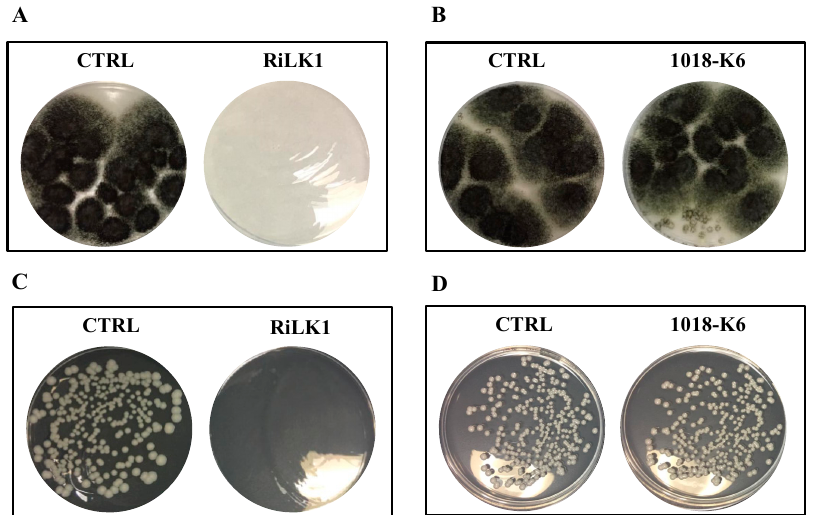
Figure 7. Antifungal activity of RiLK1 and 1018 ‐ K6 against pathogenic fungi. ( A , B ) Aspergillus brasiliensis and ( C , D ) Candida albicans . The fungal cultures untreated (CTRL) or treated with the peptides at 25 μ M concentration were seeded on DG18 (Dichloran 18% Glycerol Agar) plates. The photographs are representative of three independent experiments performed in triplicate.